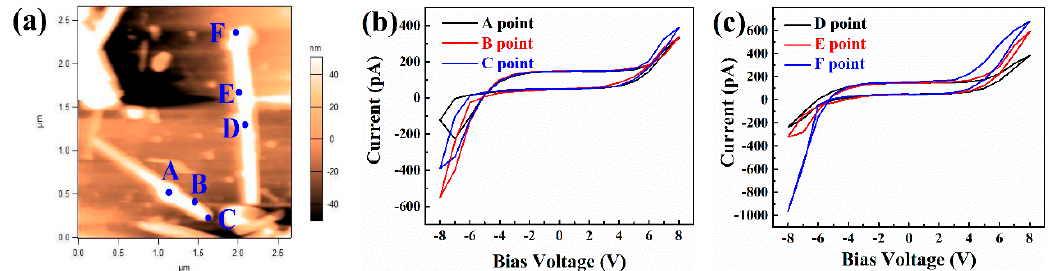
Figure 6. The topography ( a ) and I – V curves ( b , c ) of the BFO NWs at different positions.